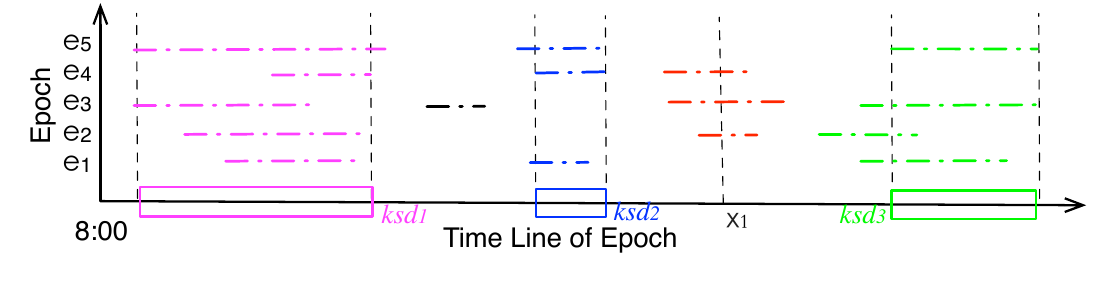
Figure 4. Mapping the maximal stationary durations ( sd ) into set of key stationary durations ( ksd ) with threshold θ = 0 . 6